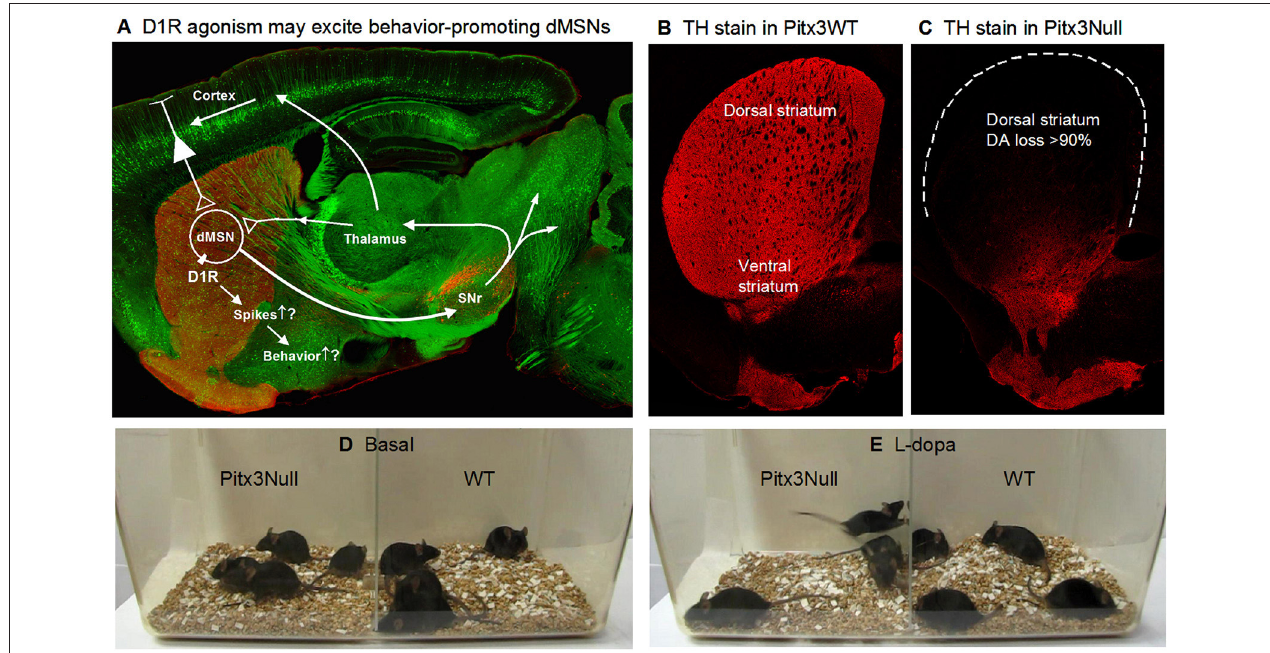
FIGURE 1 | Severe DA denervation in the dorsal striatum in Pitx3Null mice. (A) Diagram showing the dMSN-based BG motor control circuit and the possibility that D1Rs increase dMSN spike firing. The background image shows a confocal sagittal brain section outlining the key brain structures. The red is TH stain and the green is GFP to outline the basal ganglia. (B) A 3 µ m confocal section showing the intense DA innervation in the striatum in Pitx3WT mice. (C) A 3 µ m confocal section showing the dorso-ventral gradient DA denervation in the striatum in Pitx3Null mice; note the severe DA denervation in the dorsal